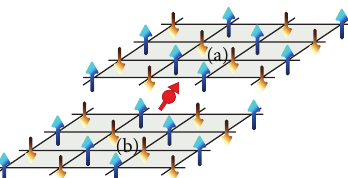
Figure 1: Central electron spin coupled to a one-dimensional anisotropic-antiferromagnetic spin systems. The spin configuration is compatible with the spin state in a sublattice (i.e., the spins on each sublattice are antiparallel). (a) and (b) represent physical configuration of a two-interpenetrating quantum spin